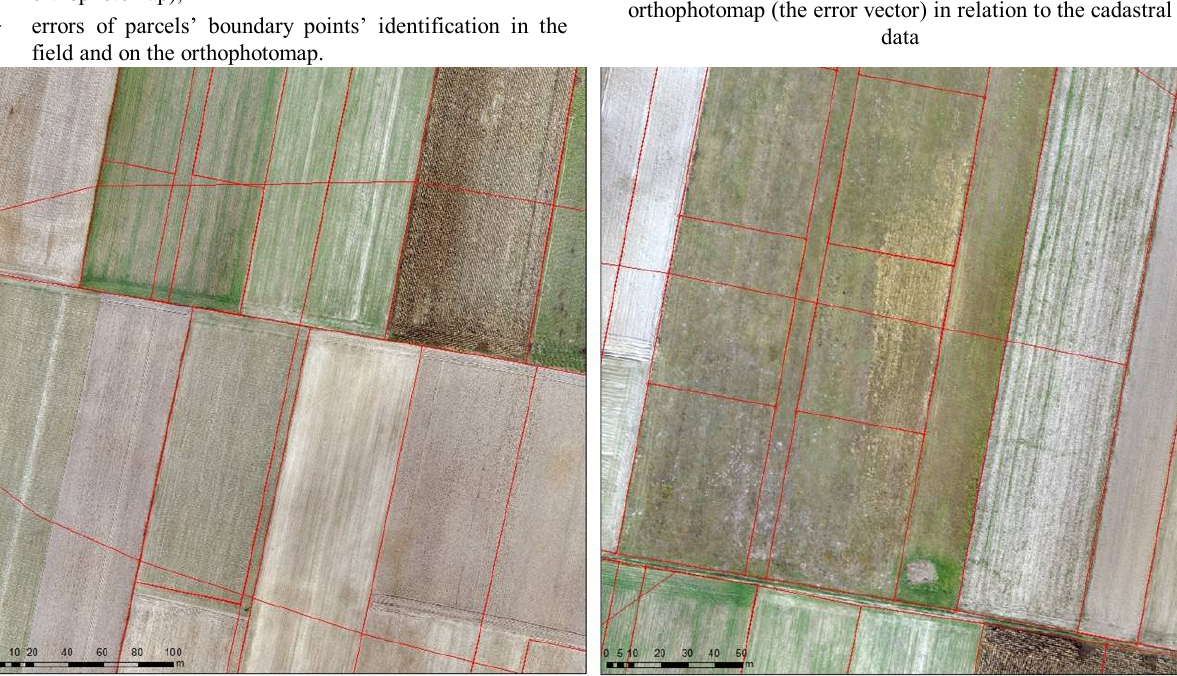
Figure 7. An example of discrepancies between boundaries existing in the cadastre and real land-use conditions detected on the basis of products from the UAS